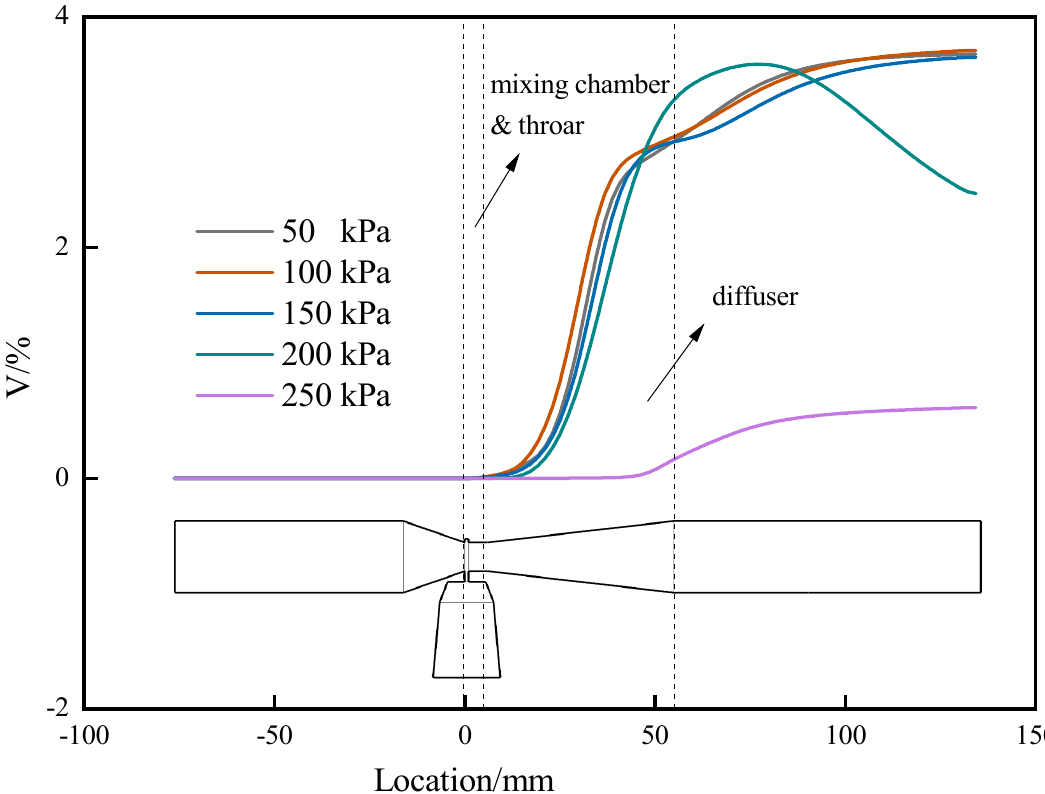
ff erent outlet